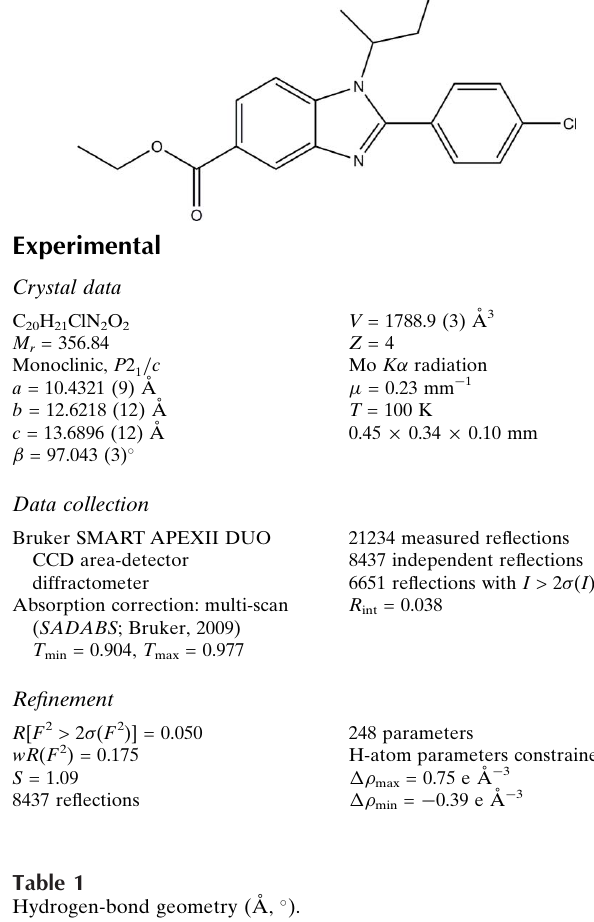
Hydrogen-bond geometry (A˚ , (cid:2)